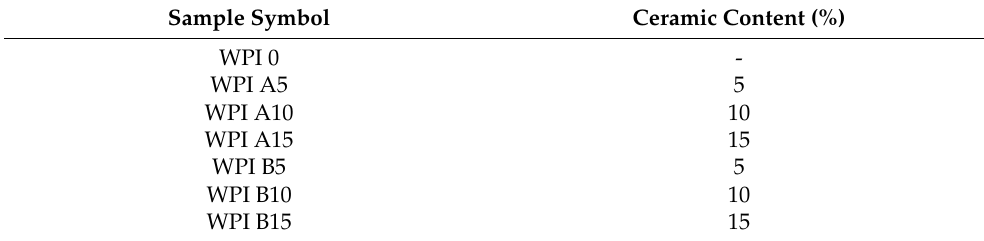
Table 1. Percentage share of ceramics in hydrogels WPI/HAp.